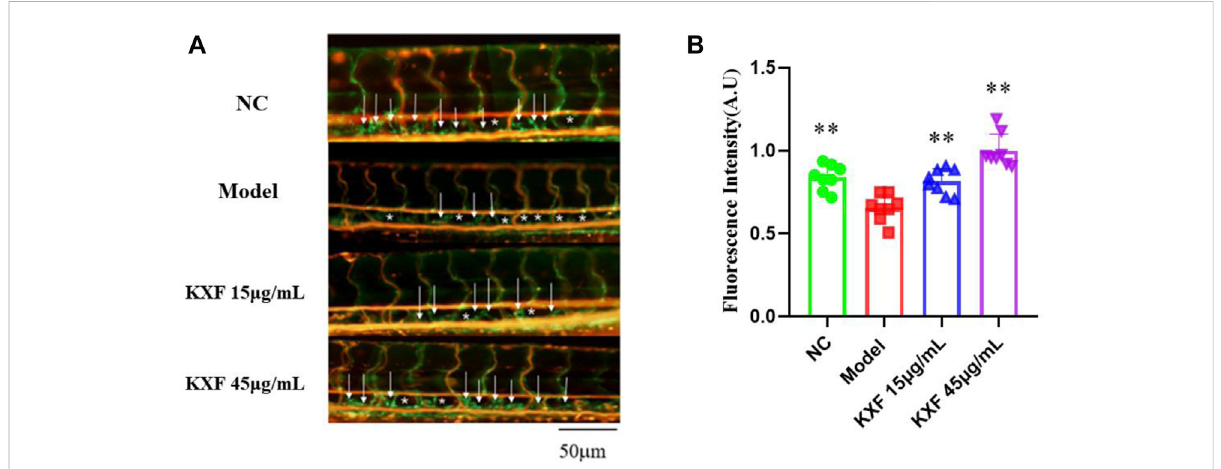
FIGURE 7 Impaired lymphatic thoracic duct formation induced by VEGFR-3 kinase inhibitor (MAZ51) was rescued by KXF. (A) . Representative confocal images show that KXF promoted the thoracic lymphatic duct formation in zebra fi sh. The white arrow indicates the thoracic lymphatic duct, and the white star indicates a lack of lymphatic vessels; (B) . Quantitation of the fl uorescence intensity of the thoracic lymphatic duct. * * p < 0.01 vs. model group.